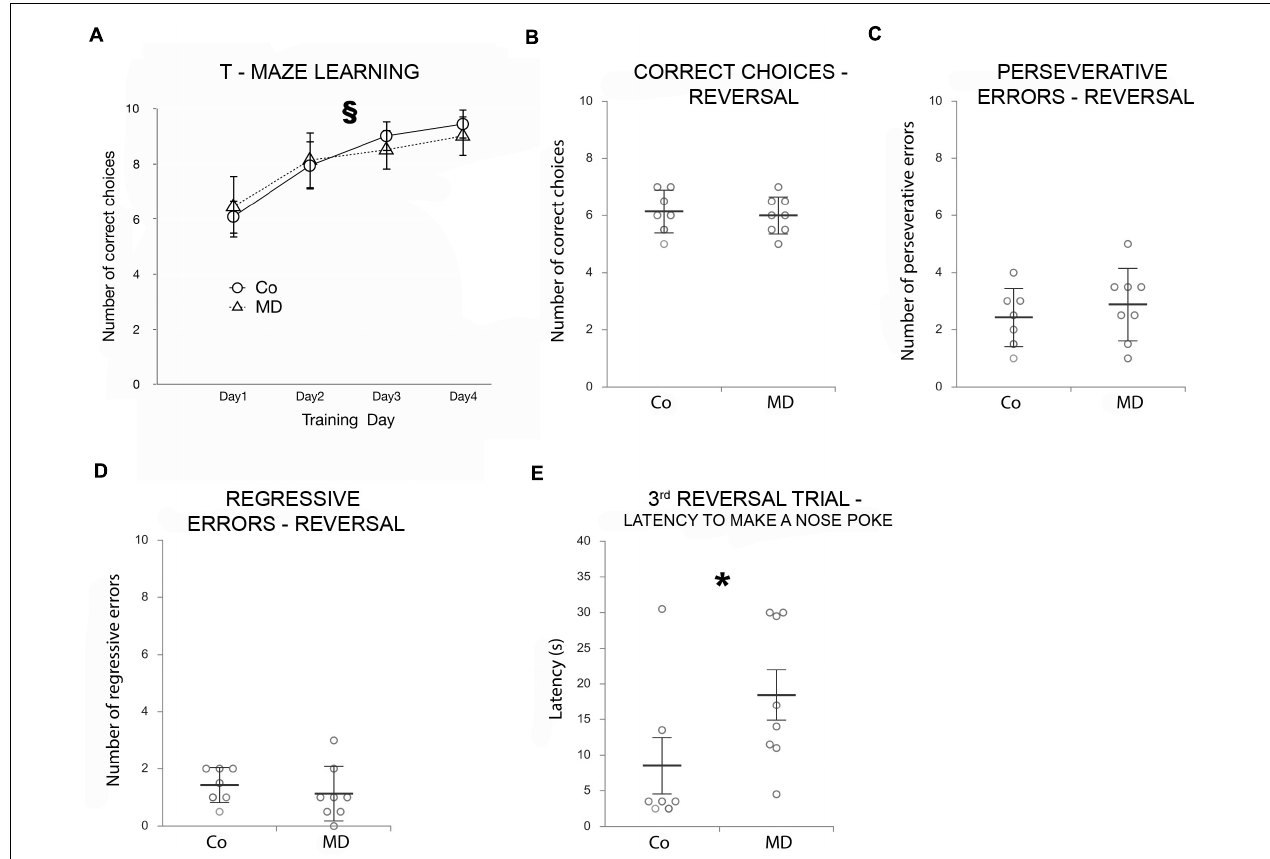
FIGURE 1 | Effects of MD on T-maze learning and reversal learning as determined by a T-maze Behavioral flexibility task. Points in graphs in (A) represent means ± SD and dot plot graphs in (B–E) represent means ± SD (horizontal bars in B–D ) or ± SEM (horizontal bars in E ) and observed values (dots), n = 7 for Co, n = 8 for MD (the average value of two animals from each litter was used in the statistical analysis and for the construction of graphs). (A) Both groups of animals improved their performance across the 4 days of training, as indicated by the increasing number of correct choices as training progressed. T-maze learning ability did not differ between Co and MD. No statistical differences in the number of correct choices (B) , perseverative (C) , or regressive errors (D) were found between Co and MD during the reversal phase. MD rats showed a mild reversal learning deficit, as indicated by the more time it took them to make a nose poke during the third reversal trial when compared with Co animals (E) . § p < 0.001 improvements in learning behavior across training days irrespective of treatment, * p < 0.001 Co vs. MD. Co control, MD maternally deprived rats.